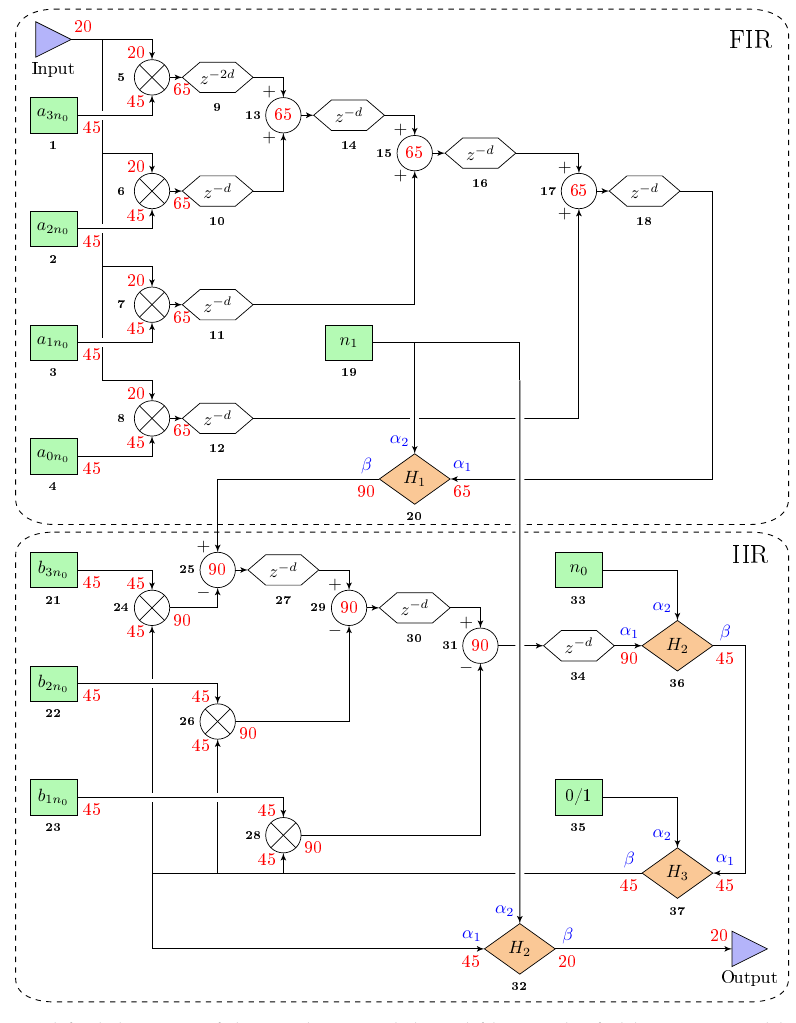
Figure 5. Simplified diagram of the implemented digital filter in the field programmable gate array (FPGA) and representing resonator 1 in Figure 1. The black and bold numbers are the blocks identifiers. The numbers in red correspond to the number of bits on which the numbers are encoded and d is the decimation factor. The hexagonal blocks are registers, the circular ones with a cross inside are multipliers, the green blocks are tunable values, and the orange ones are custom sources detailed in